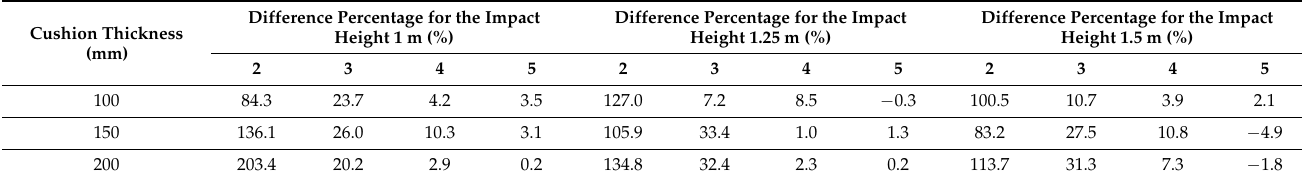
Table 3. Difference percentage of the peak acceleration under each impact relative to that of the previous impact.